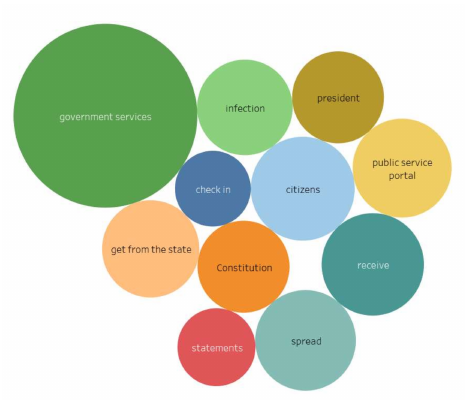
Figure 9. Associative network for stimulus state (10/24,393), regional actors).